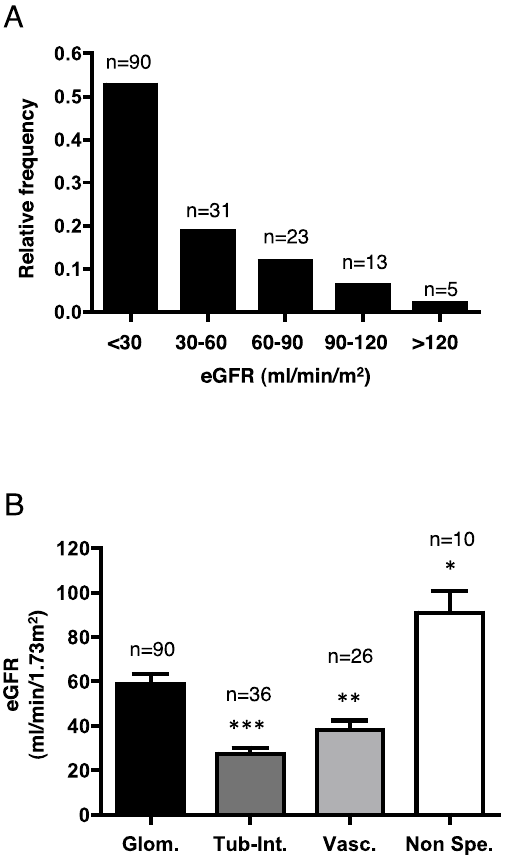
Figure 1. Distribution of estimated glomerular filtration rates. A . Histogram showing the distribution of the study population according to the eGFR level at inclusion. B . Histogram showing eGFR values according to the type of kidney disease. eGFR is expressed as the mean 6 sem. *p , 0.05, **p , 0.01, ***p , 0.001 compared to glomerular disease using Student’s T test; the Mann-Whitney test was used for the glomerular vs. comparison with non-specific lesions. Glom: glomerular diseases; Tub-Int: tubular and/or interstitial diseases; Vasc: vascular diseases; Non-spe: non-specific.